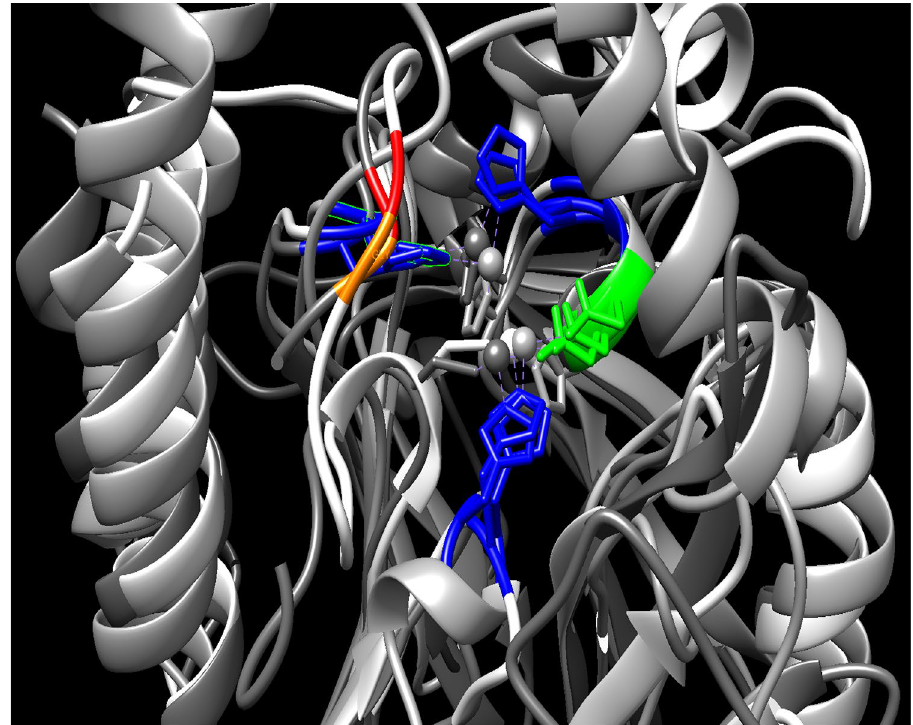
Figure 8. Crucial residue in active site, which conserve in the MBL. These amino acids pass from protein sequence alignment level. Histidine, Aspartic acids, Gly and Asn residues are colored Navy blue, green, orange and red,